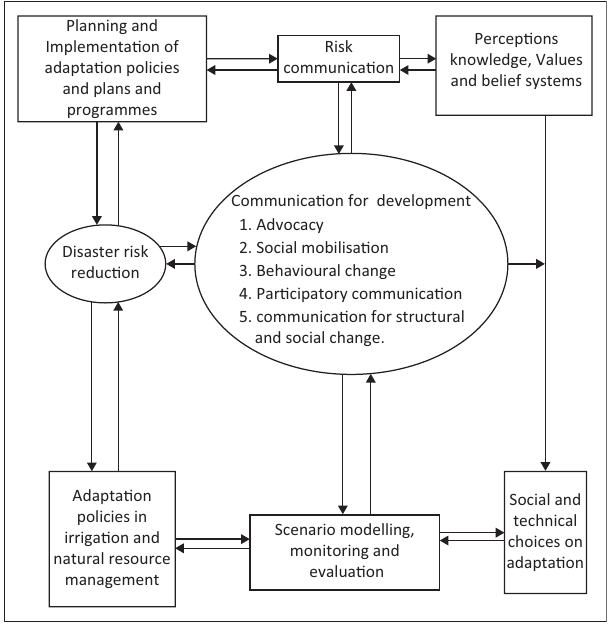
FIG URE 1: Authors’ conceptual framework on integration between risk communication and sustainable climate change